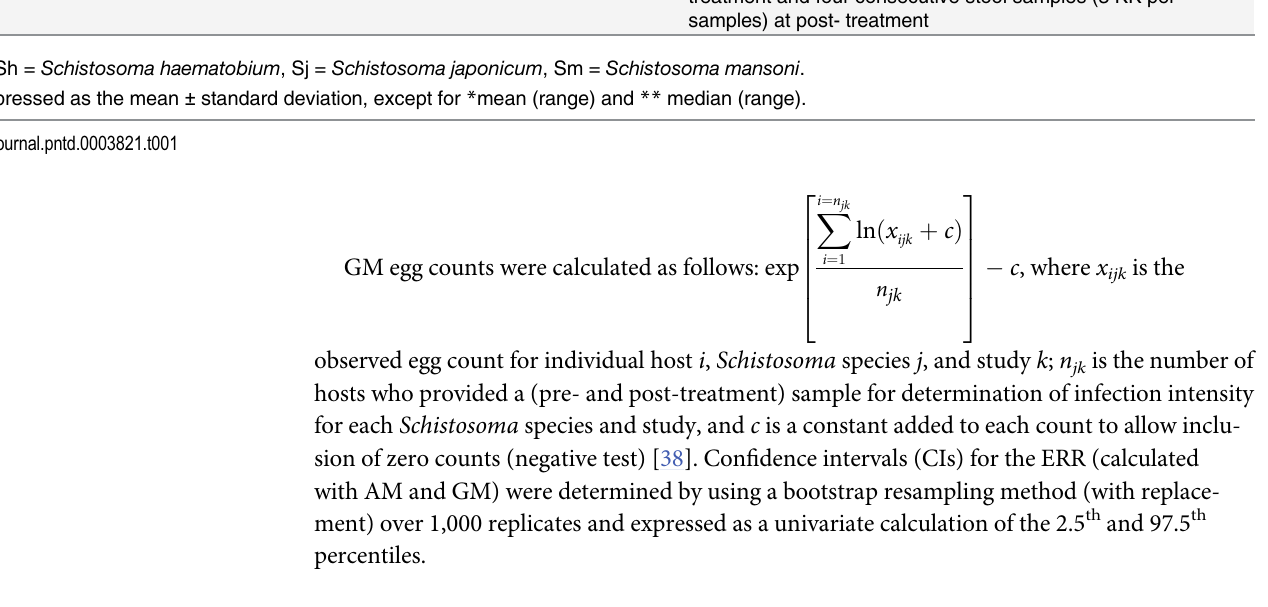
observed egg count for individual host i , Schistosoma species j , and study k ; n jk is the number of hosts who provided a (pre- and post-treatment) sample for determination of infection intensity for each Schistosoma species and study, and c is a constant added to each count to allow inclu- sion of zero counts (negative test) [38]. Con fi dence intervals (CIs) for the ERR (calculated with AM and GM) were determined by using a bootstrap resampling method (with replace- ment) over 1,000 replicates and expressed as a univariate calculation of the 2.5 th and 97.5 th percentiles.